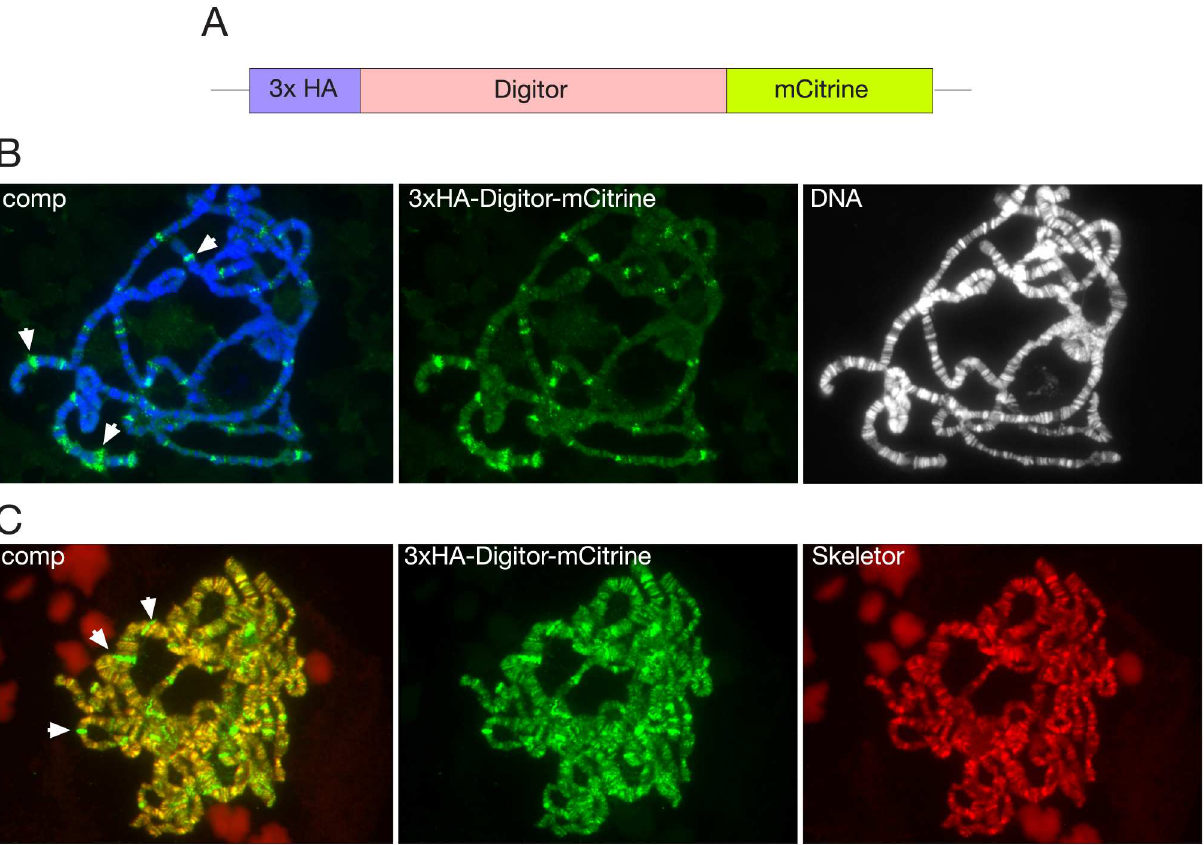
Fig 4. Transgenic expressionof 3xHA-Digitor-mCitrine in salivarygland cells. (A) Diagramof 3xHA-Digitor-mCitrine. (B) Polytene squash preparation labeledwith anti-HA antibody to detect the 3xHA-Digitor-mCitrineconstruct (in green) and with Hoechst to label DNA (in blue/grey). In the composite image (comp) examplesof developmental puff regions with higher expression of 3xHA-Digitor-mCitrineare indicatedby arrowheads. (C) Polytene squash preparation labeledwith anti-HA antibodyto detect the 3xHA-Digitor-mCitrineconstruct (in green) and with anti-Skeletorantibody (in red). In the composite image (comp) co-localization between3xHA-Digitor-mCitrine and Skeletoris indicatedby yellow/orange colors. Examples of developmental puff regions positive for 3xHA-Digitor-mCitrine but not for Skeletorare indicatedby arrowheads. The relatively low exposureof anti-HA antibody-labelingof 3xHA-Digitor-mCitrinein (B) shows the prominent labelingof the developmental puffs whereasthe longerexposure in (C) highlightsthe labelingof the weaker labeledinterband regions.